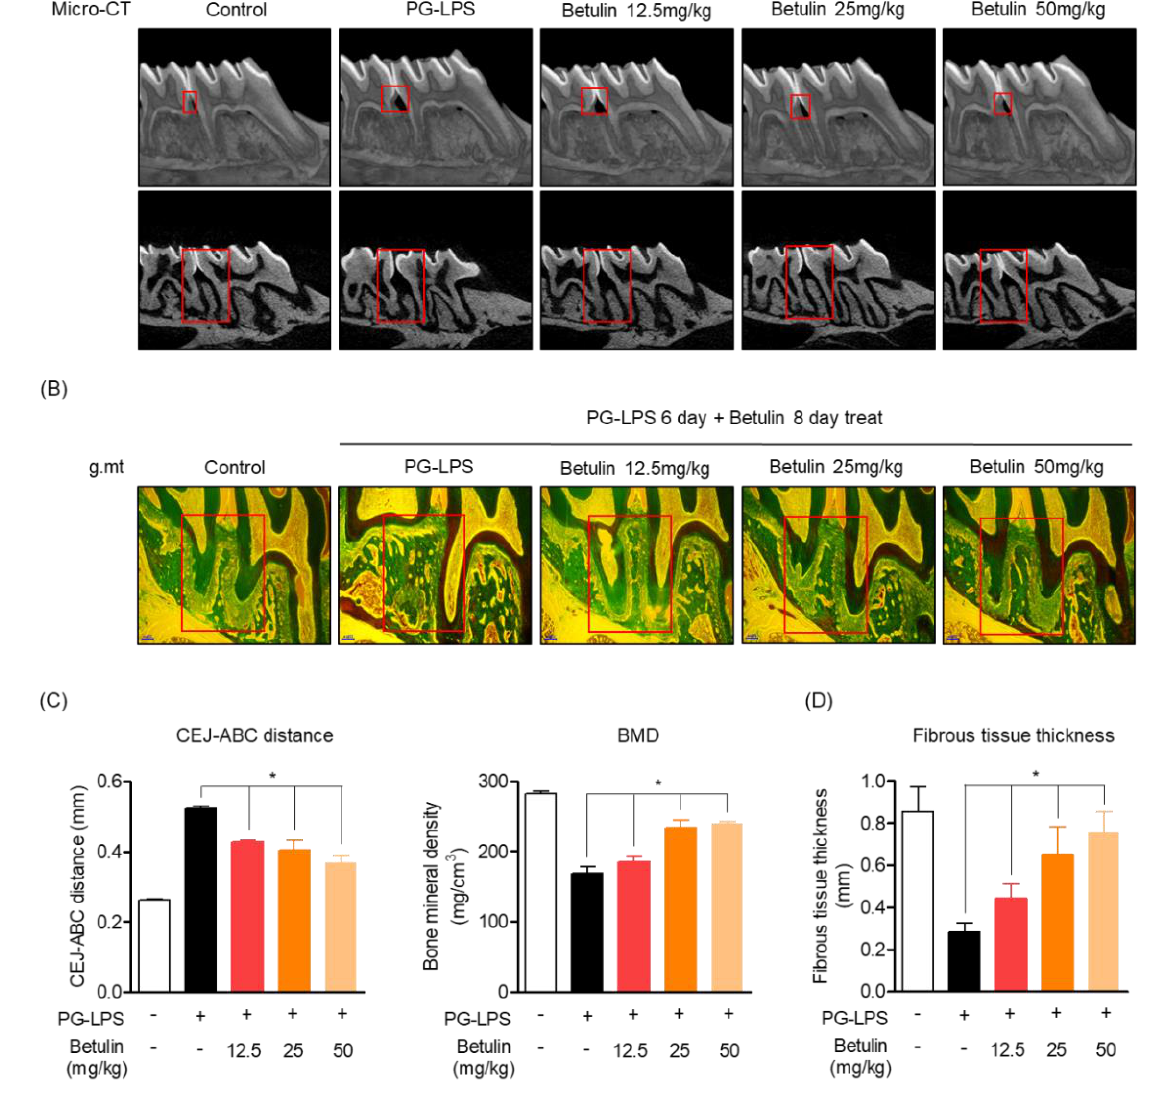
Figure 6. Protective effect of betulin on alveolar bone and fibrous tissue lost with PG-LPS in a periodontitis-induced in vivo model. Methods of inducing periodontitis in vivo models are described in materials and methods Section 2.9. The images of the alveolar bone newly formed by betulin were taken through micro-CT (3 mm) ( A ). Confirmation of periodontal fibrous tissue protective effect through Goldner’s Masson Trichrome staining ( B ). The CEJ-ABC distance and BMD were quantified through VGStudio MAX 1.2.1 software by setting the red part as the quantitative area ( C ). Measurement of the thickness of periodontal fibrous tissue by setting the red part as the quantitative area ( D ). * p < 0.05 was considered significant differences between only PG-LPS treated groups. Each group ( n = 3).